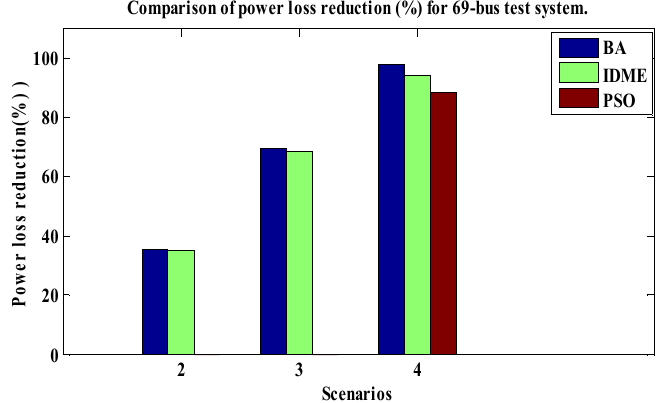
Figure 14. Comparison of power loss reduction (%) for the 69-bus test system.